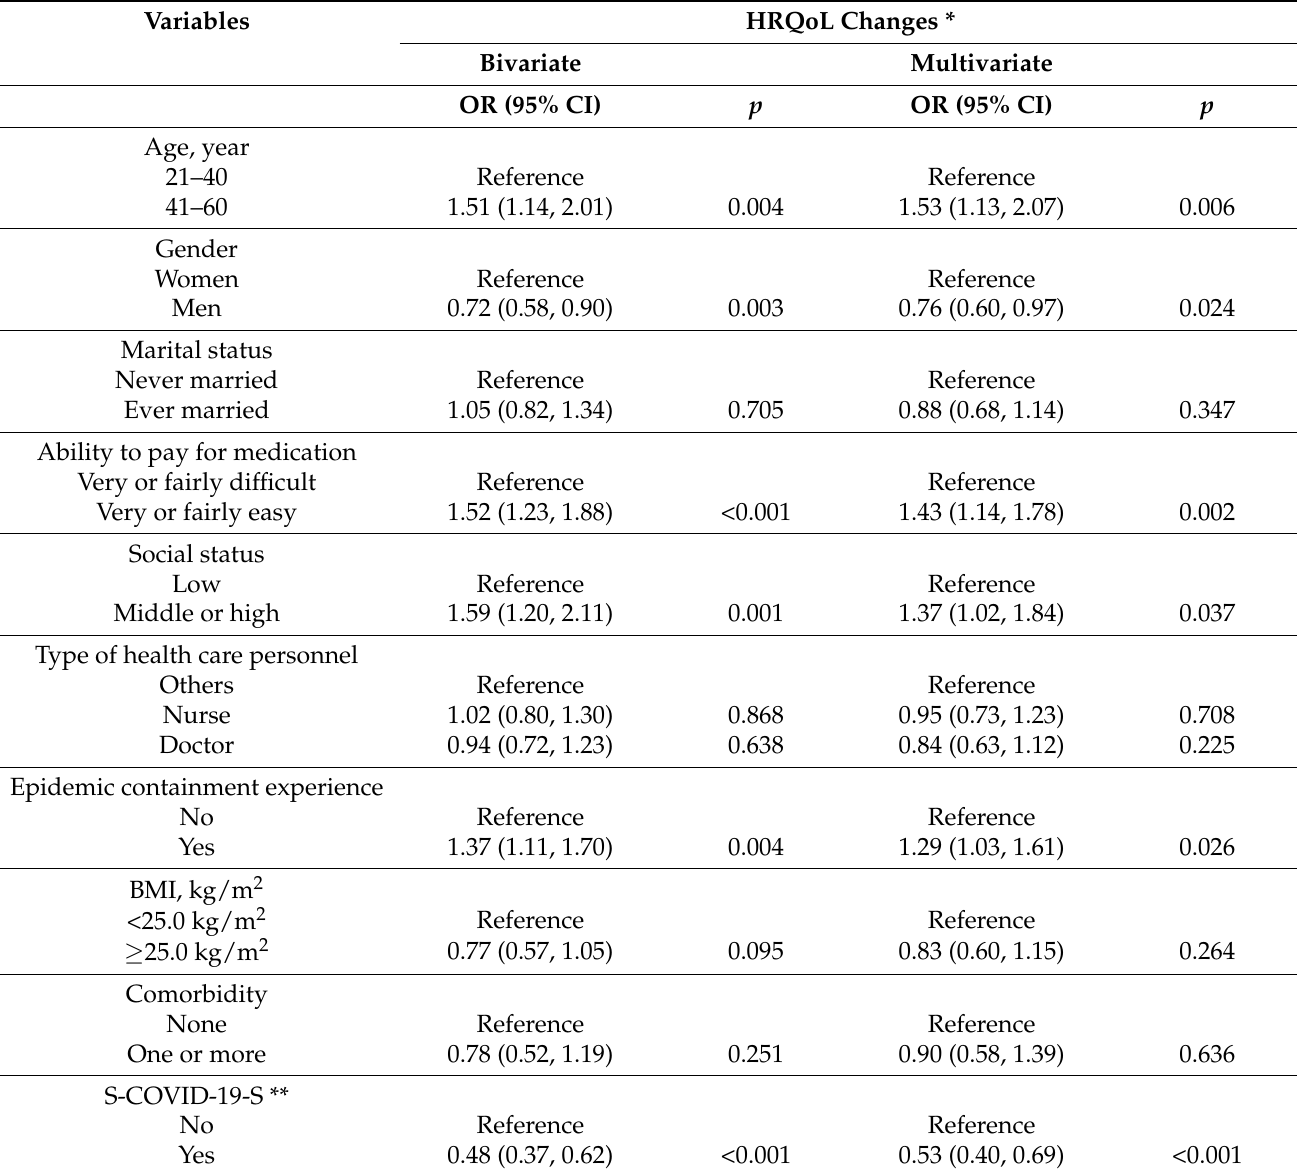
Table 4. Determinants of changes in health-related quality of life among front-line health care workers via bivariate and multivariate logistic regression models ( n =